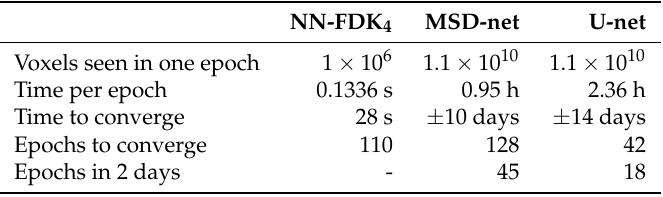
Table 2. Timings and properties of the considered training processes. We define a converged training process as 100 epochs without improvement on the validation set error. The number of epochs to converge is, therefore, the epochs computed of such a process minus 100. The training was performed using one Nvidia GeForce GTX 1080Ti GPU (11